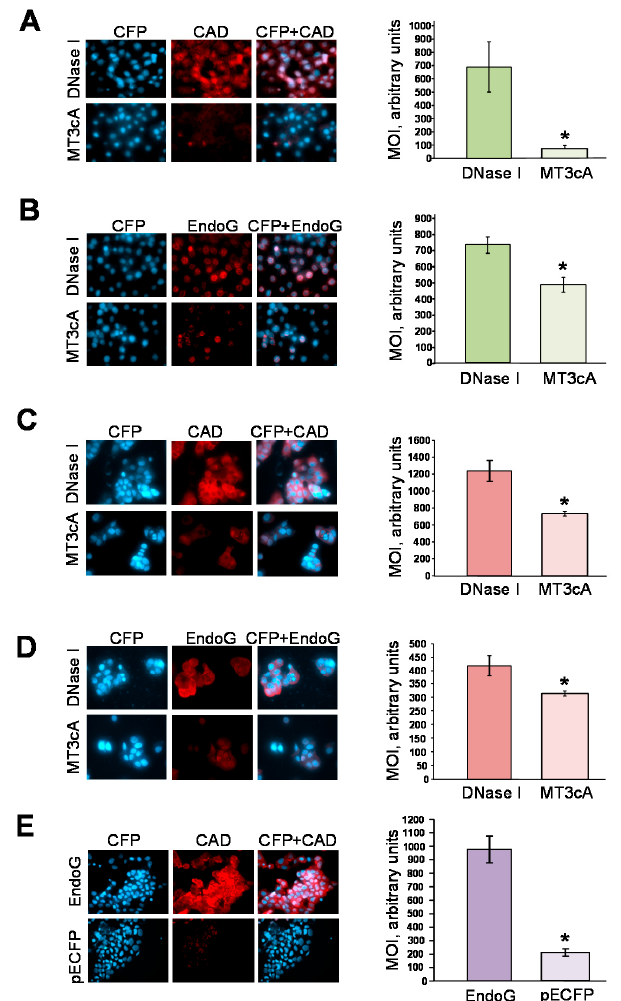
Figure 4. Inactive DNase I mutant does not induce EndoG or CAD proteins, while EndoG induces CAD. ( A ) CAD immunostaining and quantification of mean optical density (MOD) in NRK-52E cells 8 h after transfection with pECFP-DNase I or pECFP-MT3cA (* p < 0.01 compared to pECFP-MT3cA). ( B ) EndoG immunostaining and quantification of MOD in NRK-52E cells 4 h after transfection with pECFP-DNase I or pECFP-MT3cA (* p < 0.05 compared to pECFP-MT3cA). ( C ) CAD immunostaining and quantification of MOD in ZR-75-1 cells 8 h after transfection with pECFP-DNase I or pECFP-MT3cA (* p < 0.01 compared to pECFP-MT3cA). ( D ) EndoG immunostaining and quantification of MOD in ZR-75-1 cells 4 h after transfection with pECFP-DNase I or pECFP-MT3cA (* p < 0.05 compared to pECFP-MT3cA). ( E ) CAD immunostaining and quantification of MOD in NRK-52E cells transfected with pECFP-EndoG or pECFP 4 h after transfection (* p < 0.01 compared to